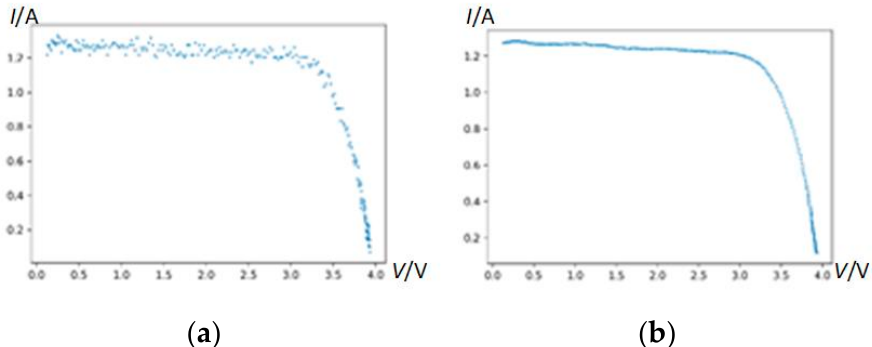
Figure 19. The I-V curve of the mini-PV module of six single cells fabricated. ( a ) Raw data. ( b ) Filtered data.